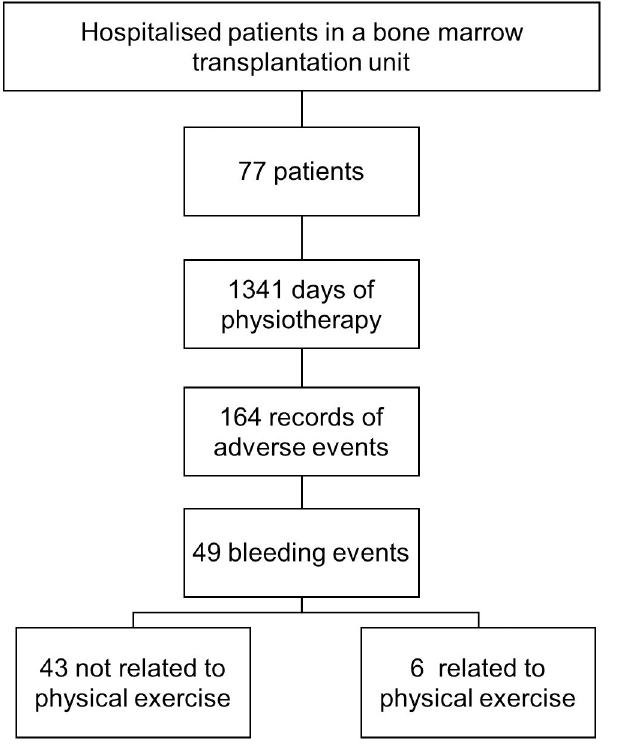
Fig 1. Number of patients, number of adverse events and number of bleeding-related or not to physical exercise.